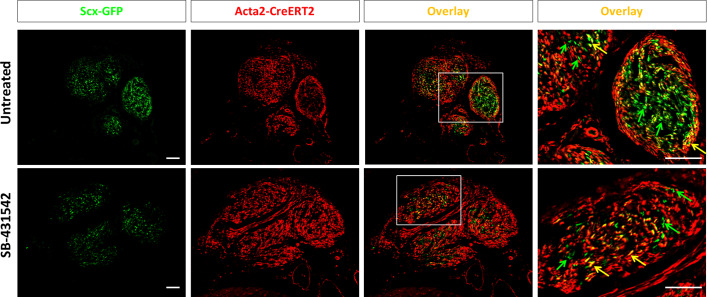
αSMAlin cells are recruited by d14 post-injury but do not account for all Scx-GFP+ cells.Labeling with Acta2-CreERT2 (P2, P3 with P5 injury) shows the αSMAlin population comprises both Scx-GFP- and Scx-GFP+ cells at d14. In both untreated and SB-431542 treated tendons, a population of Scx-GFP-only cells is observed.